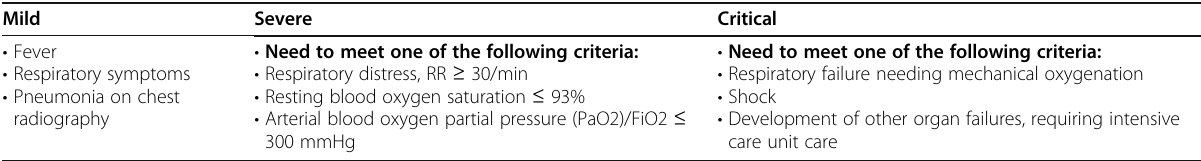
Table 1 COVID-19 severity